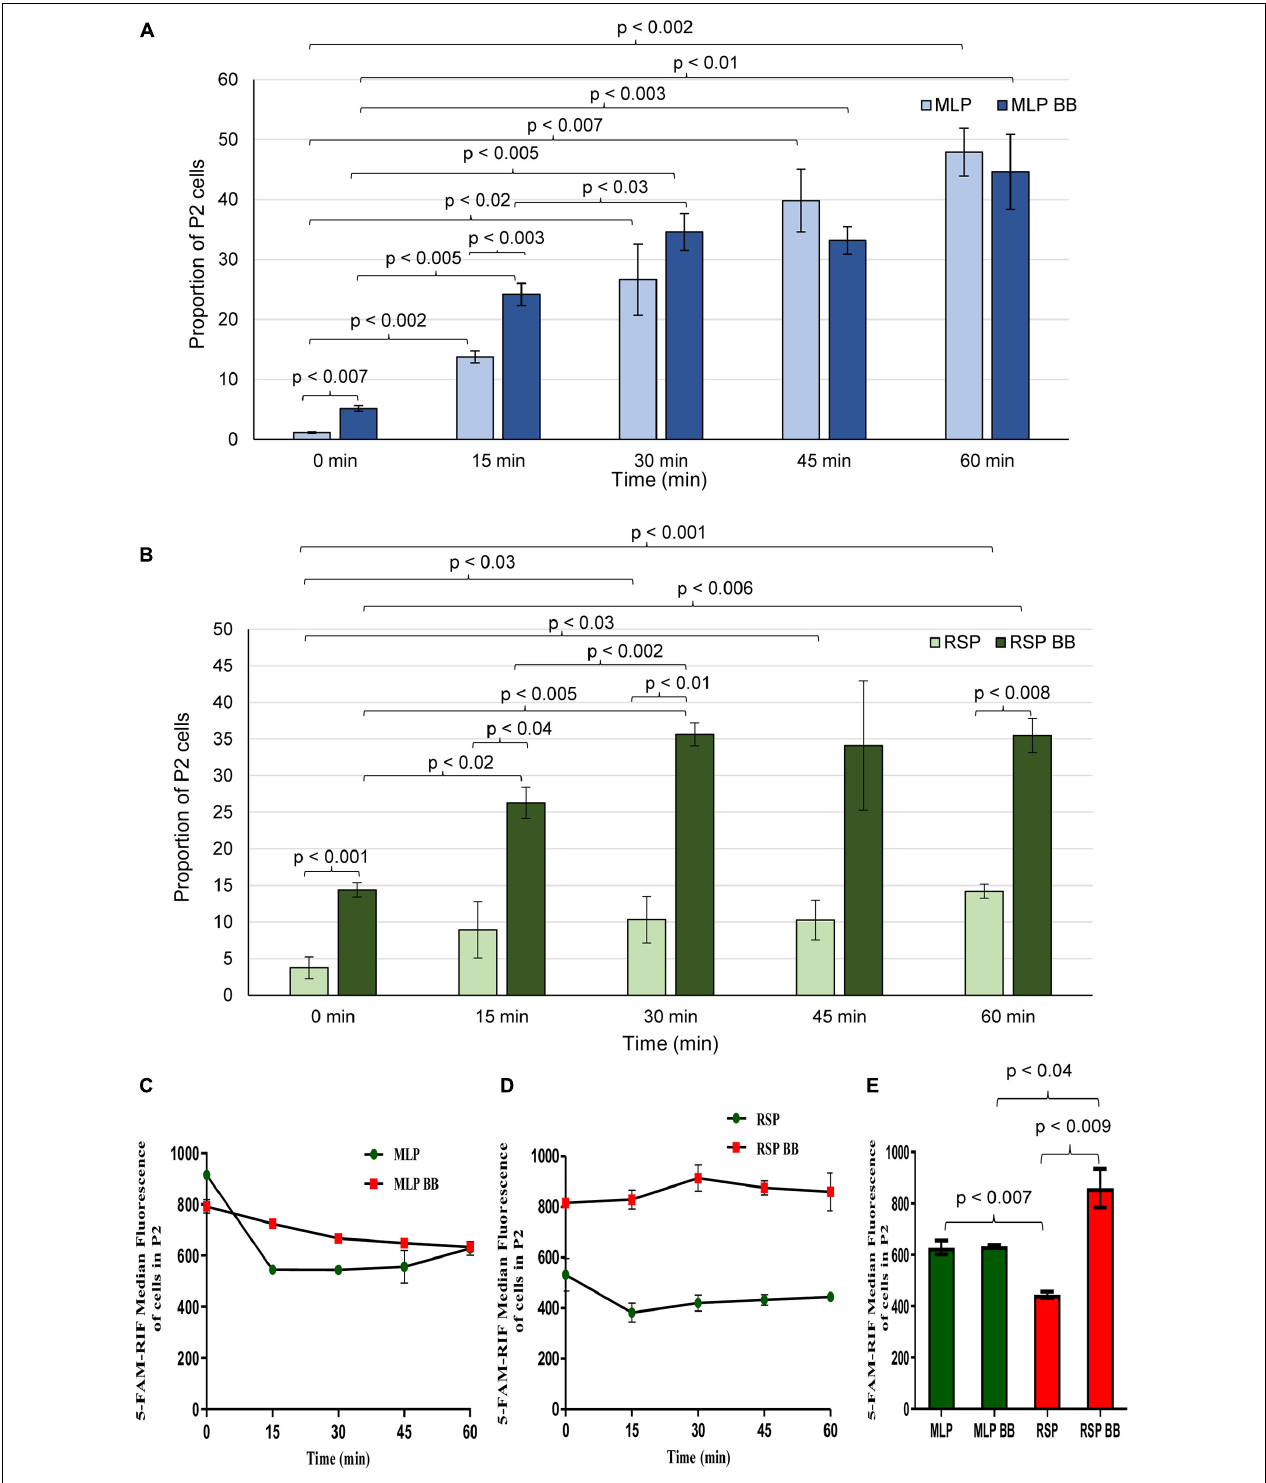
FIGURE 2 | Flow cytometric analysis of 5-FAM-rifampicin permeability into Mtb MLP and RSP cells before and after bead beating. Bar graph showing the proportion of MLP and RSP cells in the P2 gate during 60 min of time-dependent permeability of 5-FAM-rifampicin into: (A) MLP cells and (B) RSP cells, before and after bead beating. (C,D) Time-dependent presence of 5-FAM-rifampicin fluorescence in the P2 gated population of: (C) MLP and (D) RSP cells exposed to 5-FAM-rifampicin for 60 min. (E) Quantitative significant difference between the 5-FAM-rifampicin median fluorescence of the P2 gated population of MLP and RSP cells at 60 min, before and after bead beating. Statistical significance was calculated using paired t- test ( n = 3).